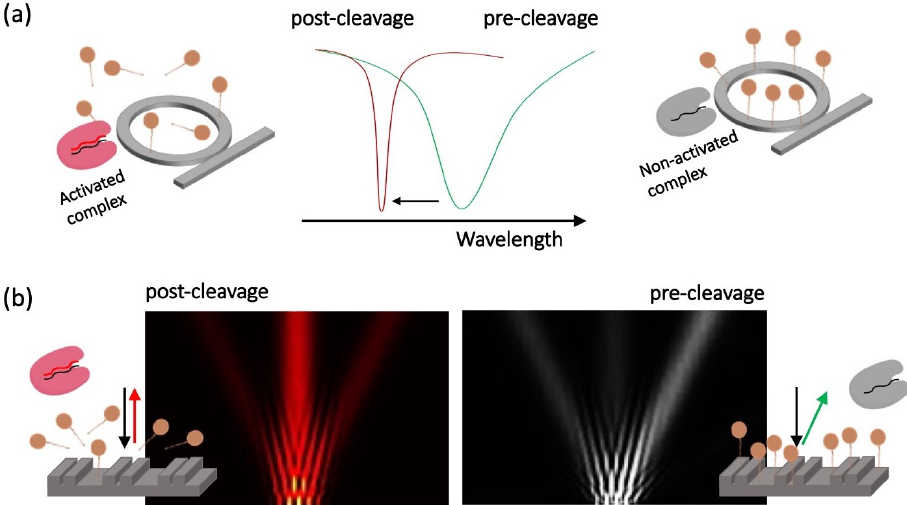
Figure 5. High-Q [184] ( a ) and low-Q [185] ( b ) photonic biosensors designed to operate in the cleavage-based detection regime, which can combine optical signal amplification with the biological recognition and collateral cleavage amplification capabilities of CRISPR–Cas complexes. ( a ) Cleavage and removal of multiple nanoparticle probes from the sensor surface per each target molecule may result in a large spectral shift. Multiple probes attached to a resonant elements, such as the microresonator, can degrade its quality factor and need to be chosen properly. ( b ) Photonic biosensors utilizing low-Q structures, such as a diffractive biosensor shown here, can be engineered to exhibit switchable behavior activated by the probe cleavage event. The diffracted field patterns illustrate the system switching from the second-order diffraction to the zeroth-order diffraction regime as as result of the